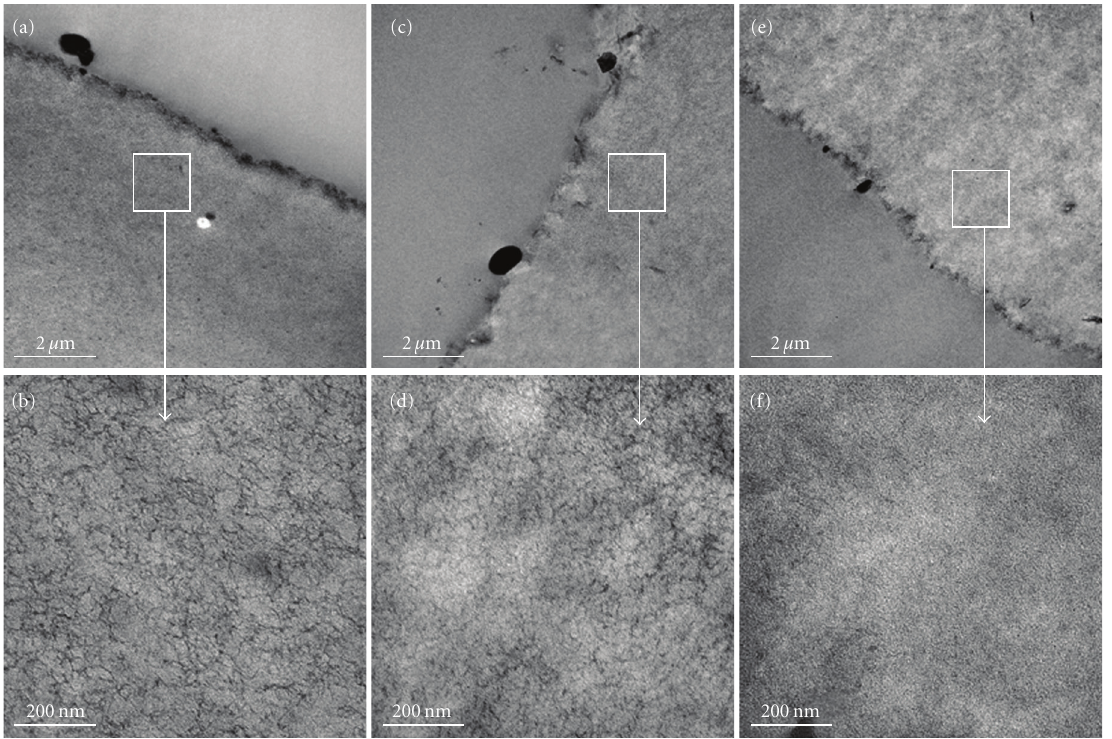
Figure 4: TEM images of the microcapsules. (a)-(b): alginate bead; (c)-(d): AC microcapsule; (e)-(f): GCAC microcapsule. (a), (c), and (e) (upper row) show the boundary regions of the microcapsule membrane; (b), (d), and (f) (lower row) depict the structural details of the square regions in the corresponding images in the upper row. Bars = 2 μ m (a), (c), (e), and 0.2 μ m (b), (d),